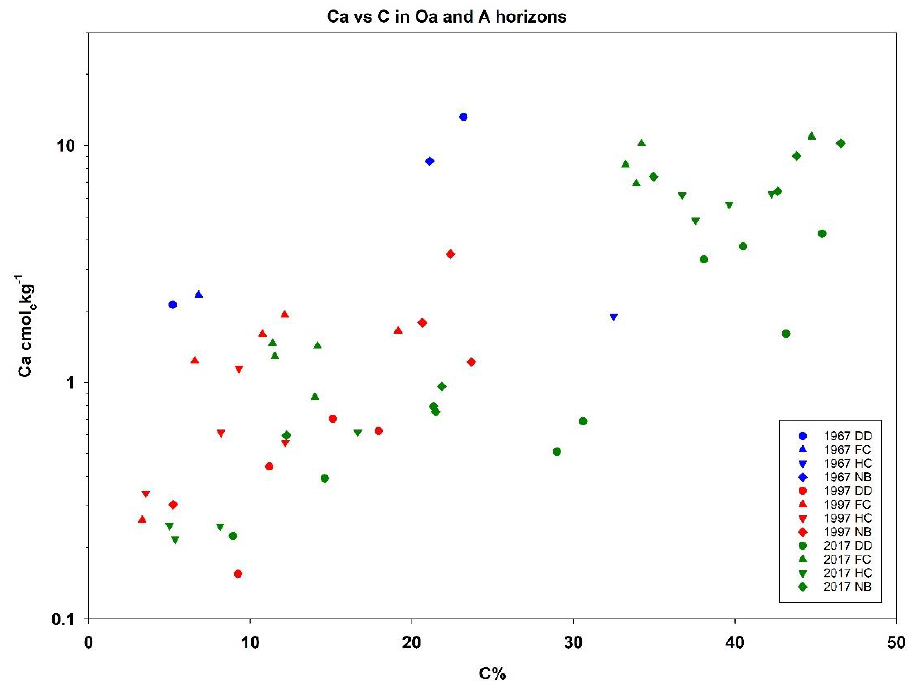
Figure 6. Exchangeable calcium vs. carbon concentration in samples of the Oa and A horizons. Color code follows the same scheme for sampling years as the soil profiles (Figures 1–5). Different symbols denote each of the four sampling sites.